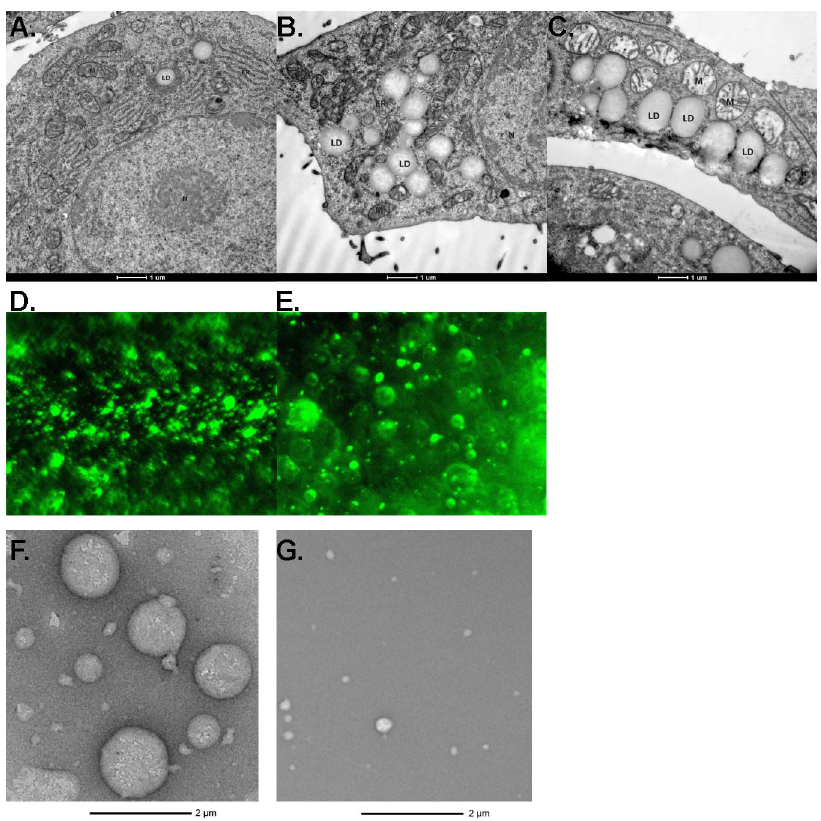
Figure 2. Visualization of lipid droplets. Electron microscopy (magnification 11,500x) of granulosa cells treated with cAMP alone ( A ), with 240 m M FA for 48 h ( B ), or with 500 m g/ml HDL for 48 h ( C ). Fluorescence microscopy of LDs isolated by differential centrifugation from granulosa cells incubated with 240 m M FA for 48 h ( D ), or with 500 m g/ml HDL for 48 h ( E ) followed by BODIPY staining. Electron microscopy (magnification 9,300x) of LDs isolated by differential centrifugation from granulosa cells incubated with 240 m M FA for 48 h ( F ), or with 500 m g/ml HDL for 48 h ( G ). M, mitochondria. LD, lipid droplet, N, nucleus. ER, endoplasmic reticulum.